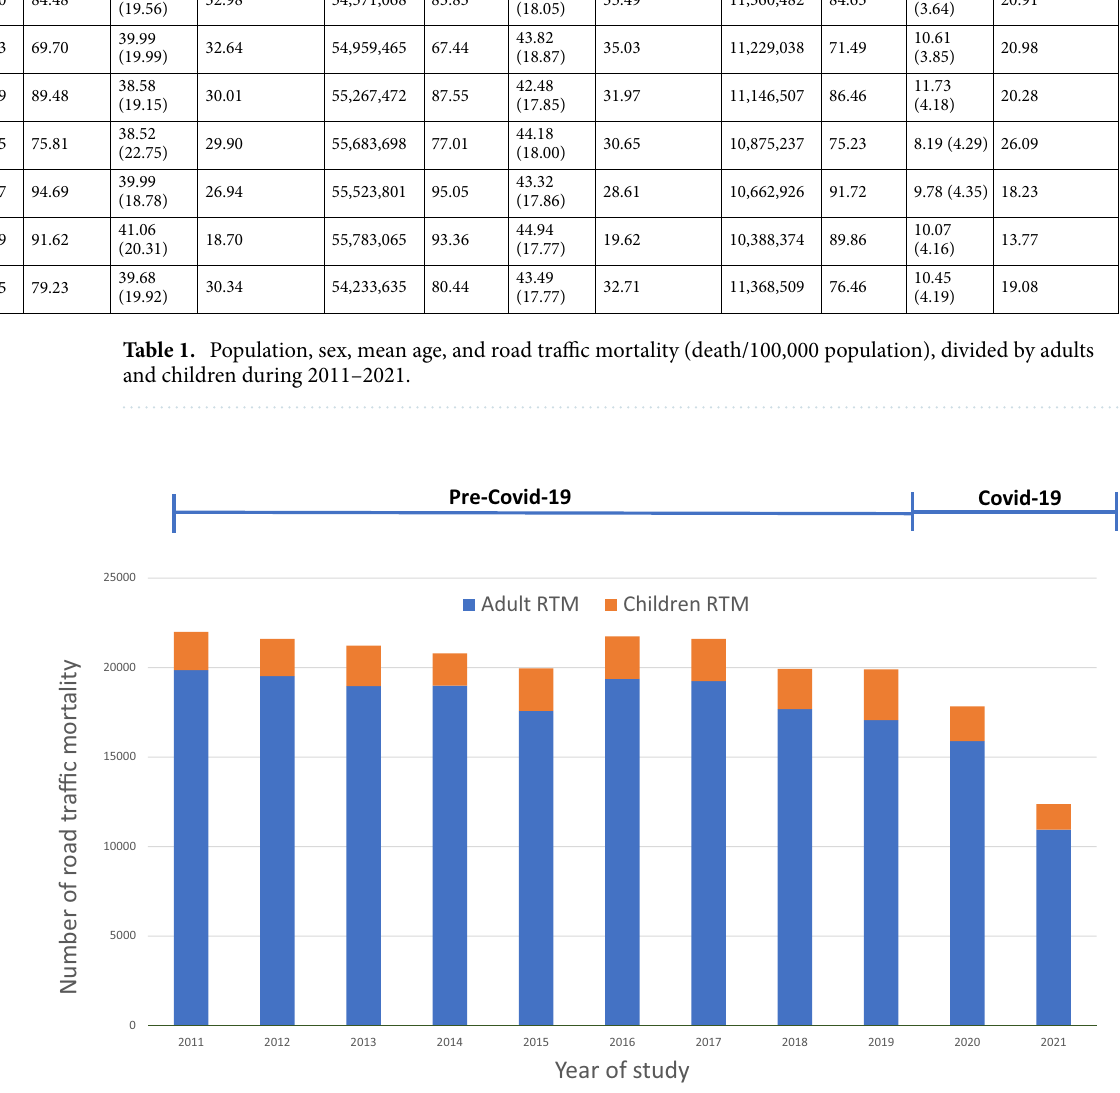
Figure 1. Number of road traffic mortalities from 2011 to 2021 (pre-Covid 19 2011–2019, Covid-19; 2020– 10 diagnosis for the cause of death was V892: person injured in unspecified motor-vehicle accident, at 43.35%, followed by V299: motorcycle rider(driver)(passenger) injured in unspecified traffic accident, at 14.12%. RTMs across each province. Rayong had the highest number of RTMs for the whole population and for adults at 62.05 and 66.94 deaths per 100,000 population respectively while Mae Hong Sorn had the fewest RTMs per 100,000 population out of all 77 provinces. Bangkok, the capital city of Thailand, had 14.41 RTMs per